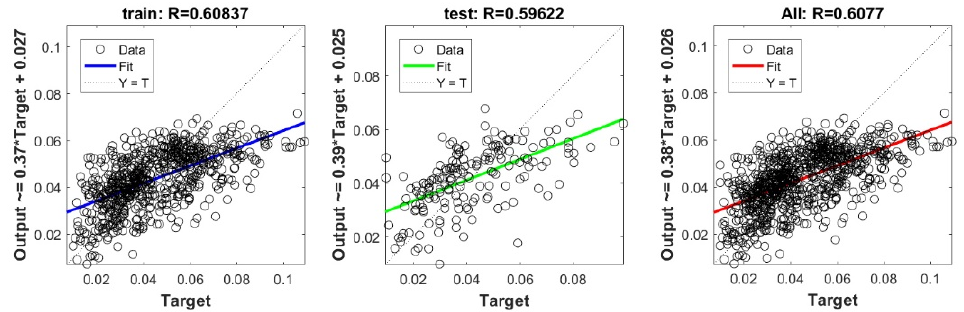
Figure A21. Scatter plots between target and output value by the PSO-DNN model.